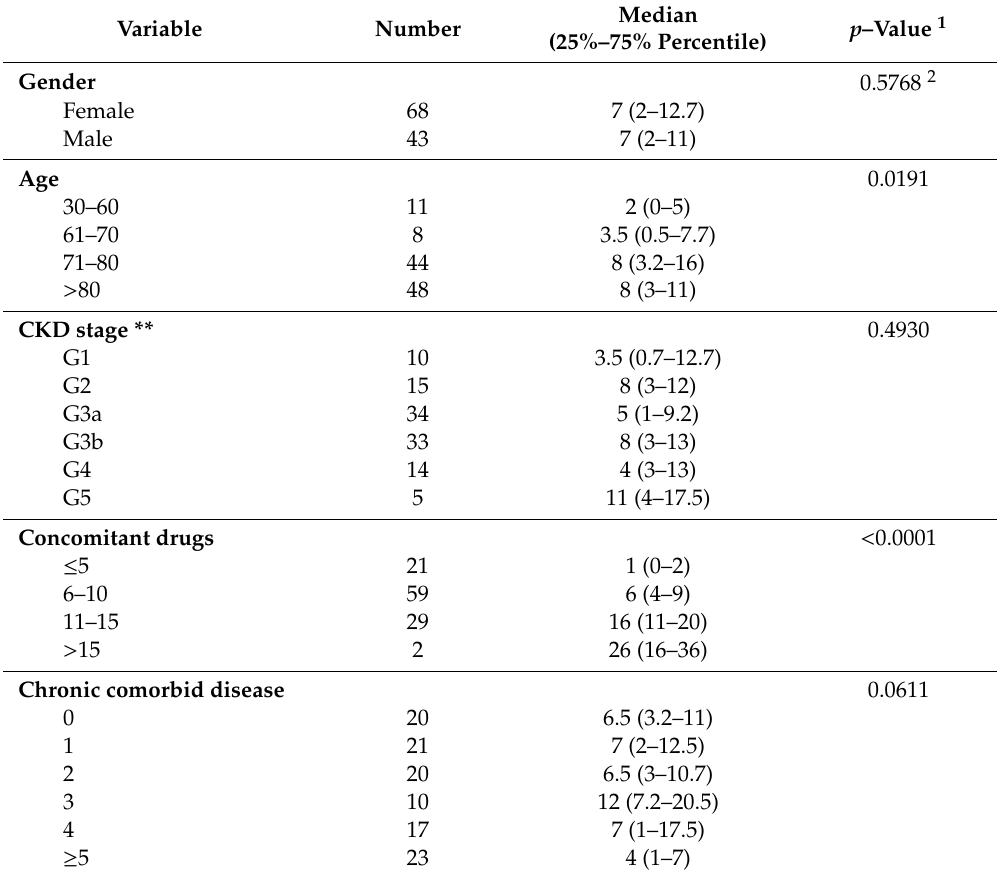
Table 6. Potential drug–drug interactions (pDDIs) among 111 * CKD patients according to demographic and clinical variables